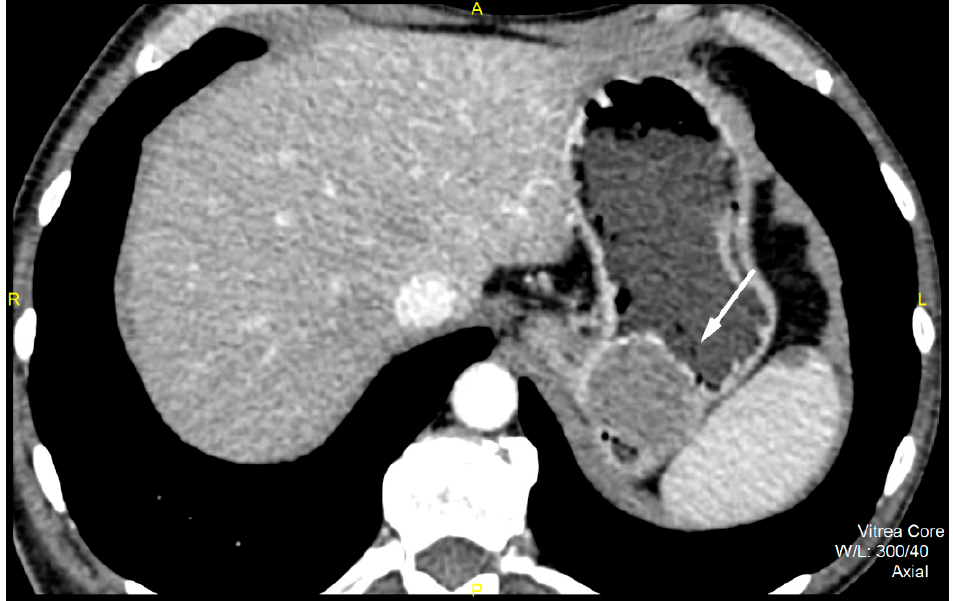
Figure 1. Contrast enhanced computed tomography of the abdomen, axial view, demonstrates low